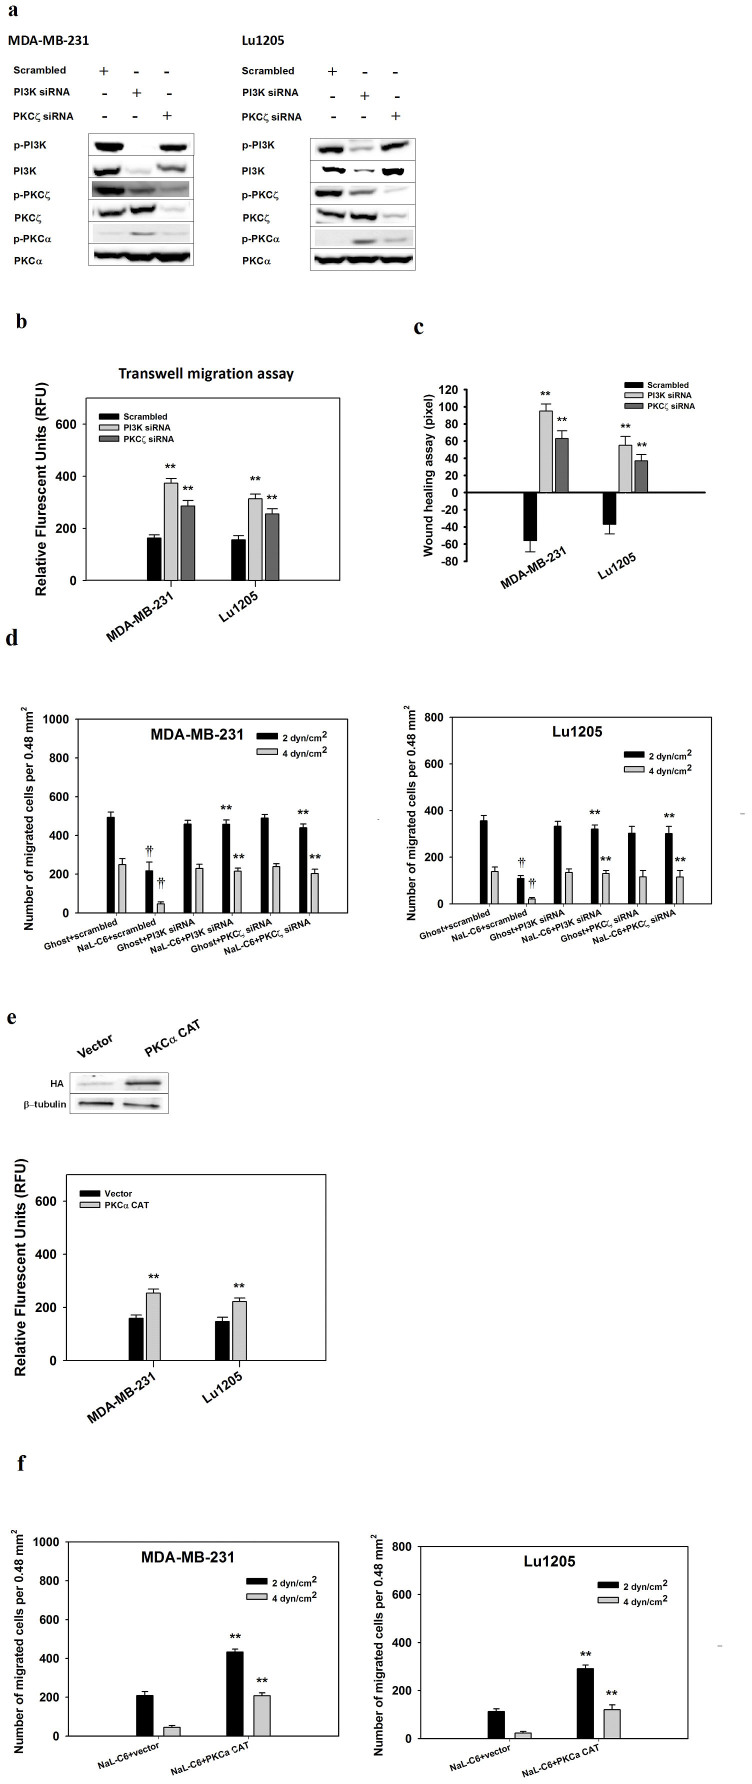
PI3K was activated upstream of PKCζ and PKCα to initiate a signaling cascade to suppress MDA-MB-231 or Lu1205 migration.(a) siRNA targeting PI3K reduced PKCζ phosphorylation and increased PKCα phosphorylation. MDA-MB-231 or Lu1205 cells were transfected with scrambled siRNA, PI3K siRNA or PKCζ siRNA before being treated with 20 μM C6 nanoliposome for 30 min. Subsequently, the cells were subject to Western blotting analysis of phosphorylated and total PI3K, PKCζ, and PKCα levels. PI3K, PKCζ and PKCα siRNAs exhibited >90% knockdown efficiencies. Data represent three replicates. (b–c) PI3K or PKCζ knockdown rescued NaL-C6-suppressed MDA-MB-231 and Lu1205 static transwell migration (b) and wounding healing potentials (c). MDA-MB-231 or Lu1205 cells were transfected with scrambled siRNA, PI3K siRNA or PKCζ siRNA before being treated with 20 μM C6 nanoliposome for 30 min. Results were expressed as mean ± SEM. n = three replicates. **p < 0.01 compared with scrambled. (d) PI3K or PKCζ knockdown rescued NaL-C6-suppressed MDA-MB-231 and Lu1205 migration at a shear stress of 2 or 4 dyn/cm2. Scrambled, PI3K or PKCζ siRNA-transfected MDA-MB-231or Lu2105 cells were treated with ghost or 20 μM C6-ceramide nanoliposomes for 30 min. Then, cells were introduced into flow migration chamber together with 1.5 mg/ml fibrinogen. The number of cells migrated after 4-hr assay was measured. Results were expressed as mean ± SEM. n = three replicates. **p < 0.01 compared with NaL-C6+scrambled; ††p < 0.01 compared with ghost+scrambled. (e–f) PKCα CAT restored NaL-C6-suppressed MDA-MB-231 and Lu1205 static transwell migration (e) and flow migration (f). MDA-MB-231 or Lu1205 cells were transfected with vector or PKCα CAT. The transfection efficiency was probed by western blotting with anti-HA antibody. Then, cells were treated with 20 μM C6-ceramide nanoliposomes for 30 min before being assessed for transwell (e) and flow migration abilities (f). **p < 0.01 compared with NaL-C6+vector.